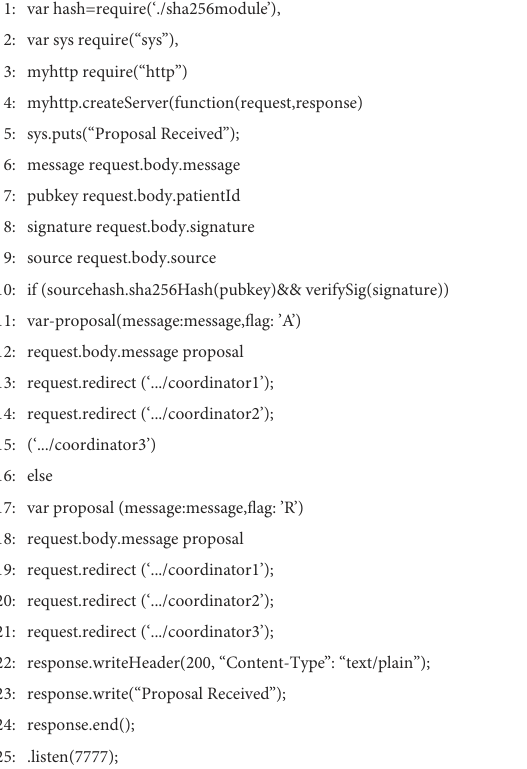
Algorithm 4 Source code of Authoritative Node.js TABLE 1 Network throughout with numerous configured